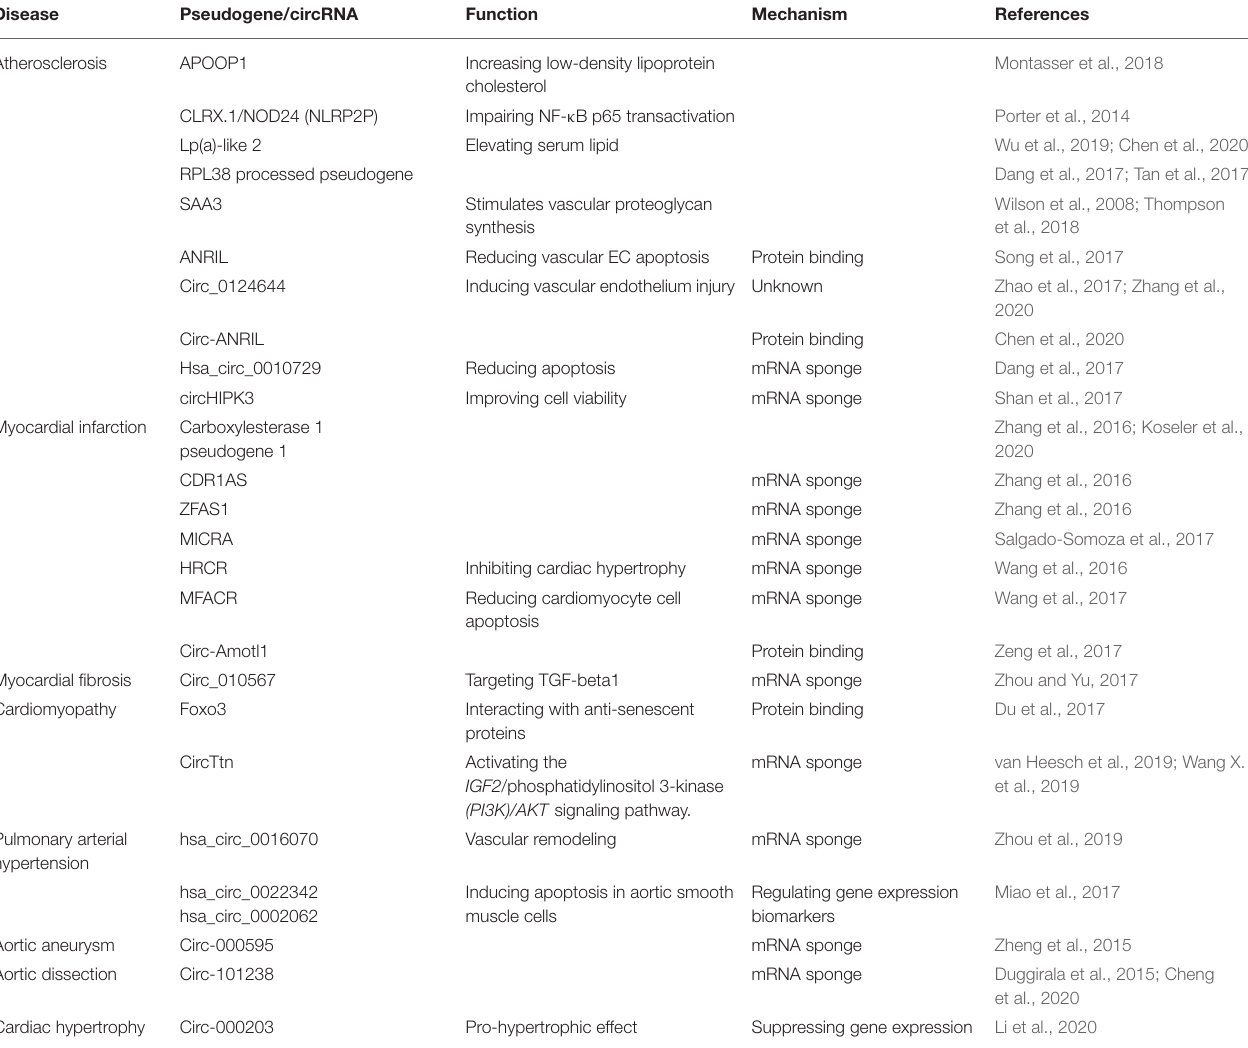
TABLE 1 | Pseudogenes and circRNAs identified in cardiovascular